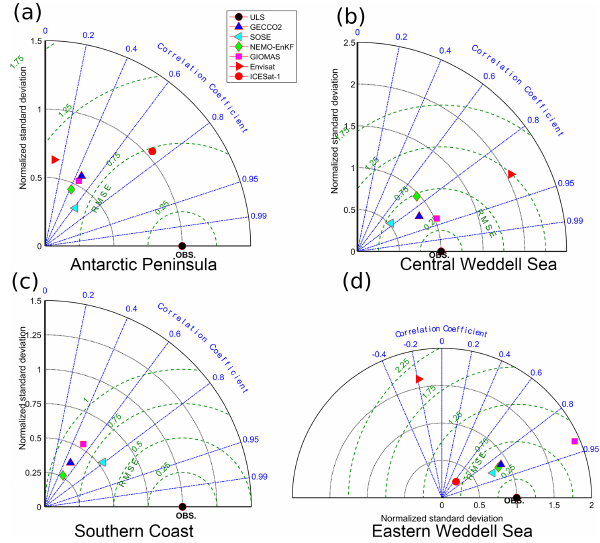
Figure 3. Same as Fig. 1b but for the four sub-regions: (a) Antarctic Peninsula, (b) central Weddell Sea, (c) southern coast and (d) east- ern Weddell